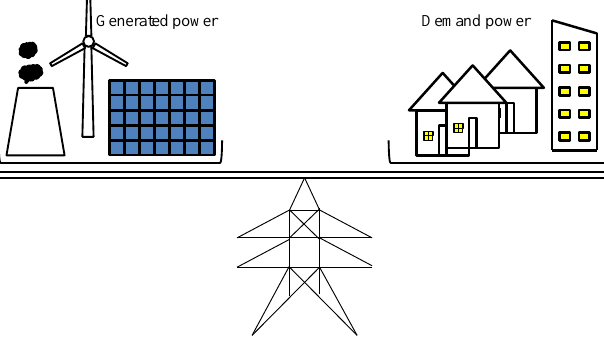
Figure 1. Power Load Balance. The balancing between the generated and consumed power, this is one of the main tasks of the distribution power system for producing power with good